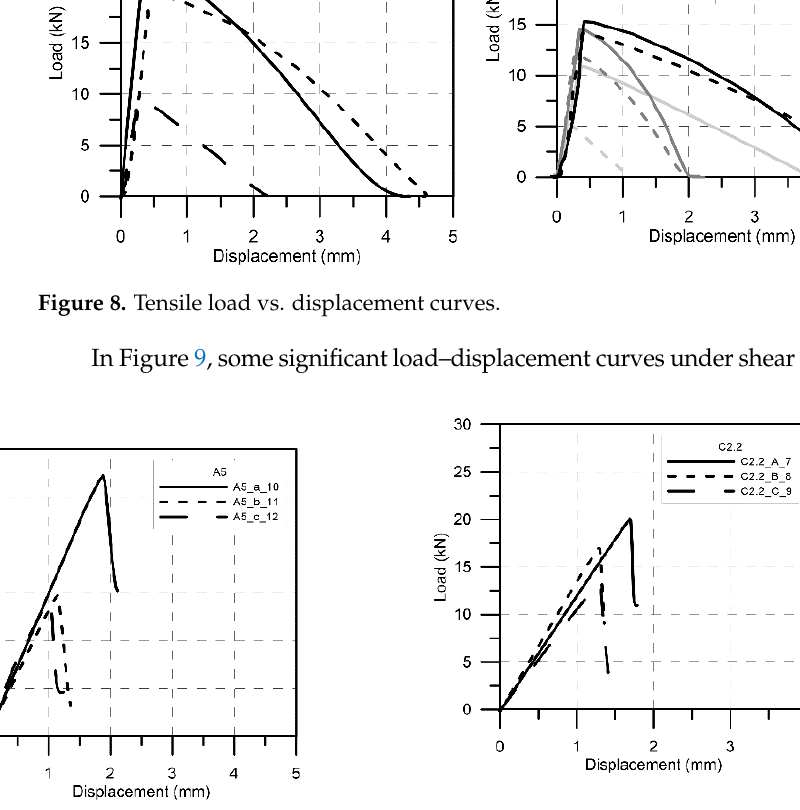
Figure 9. Shear load vs. displacement curves.